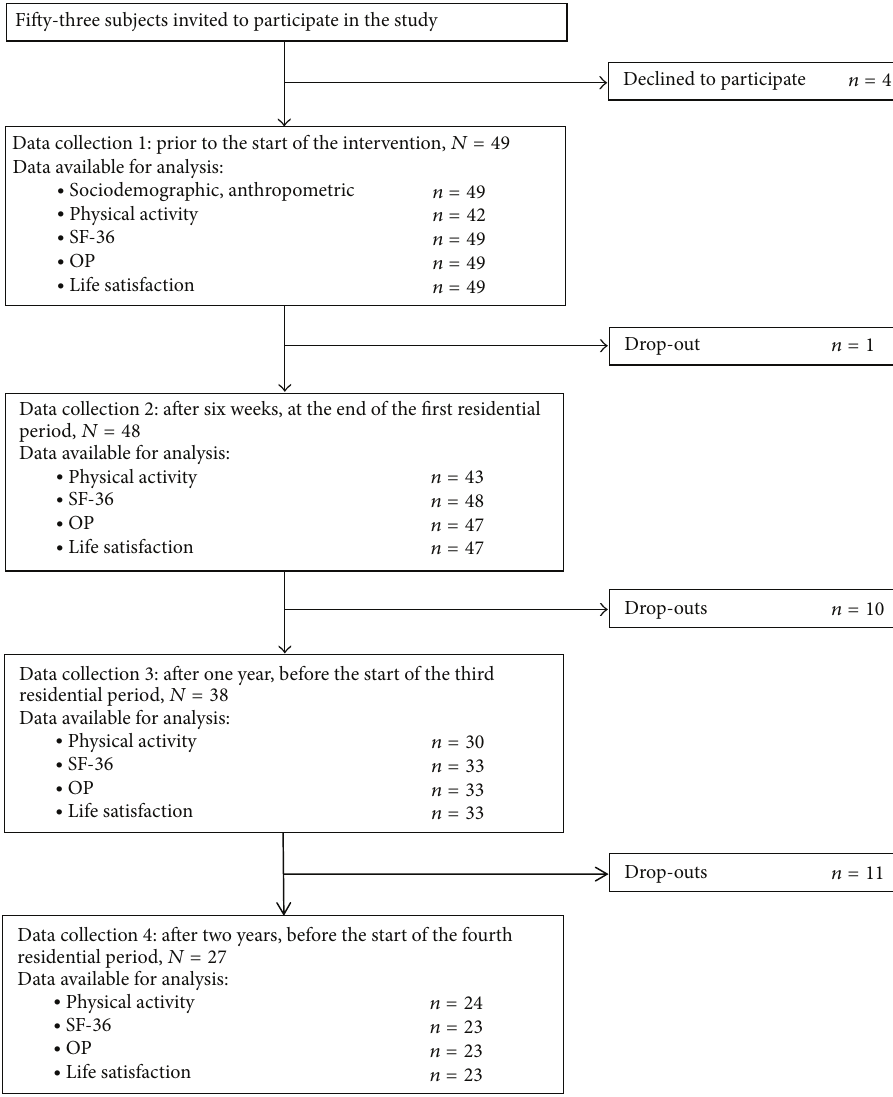
Figure 1: Flow chart for the prospective study of severely obese adults in a two-year lifestyle intervention, Medical Outcomes Study Short- Form 36 Health Survey: SF-36; Obesity-Related Problems (OP)